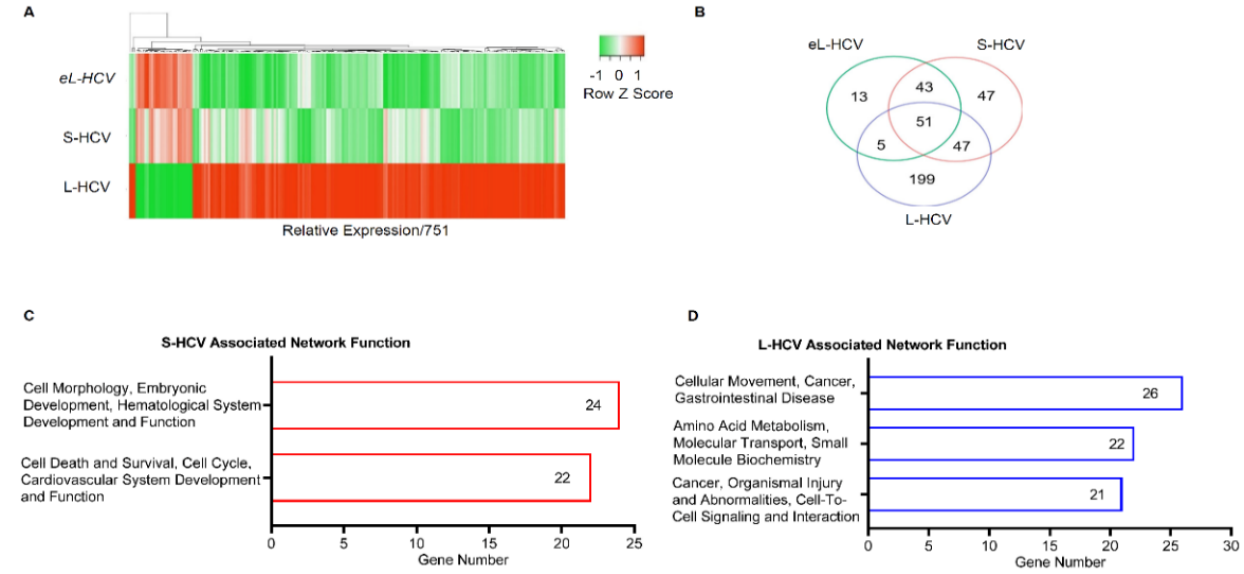
Figure 1. Intracellular HCV altered gene expression and associated diseases and bio-functions. ( A ) The heatmap demonstrating altered gene expression relative to uninfected Huh7.5.1 cells, comparing short-term HCV (S-HCV), early long-term (eL-HCV), and long-term HCV (L-HCV) using NGS gene expression data. ( B ) A Venn diagram showing the number of genes associated with S-HCV, eL-HCV, and L-HCV after a cutoff fold change ≥− 2 or ≤ 2, p < 0.05, based on NGS expression data. ( C ) Ingenuity pathway analysis (IPA) results of associated network functions showing the number of viral-load-exclusive genes implicated in the networks of S-HCV (genes = 47) and ( D ) the networks of L-HCV (genes = 199).